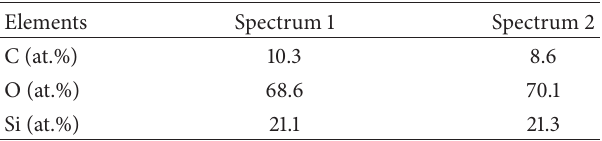
Table 3: The constituents of the black aggregates in the prepared WC-Ni cemented carbide with 3.75 wt.% SiC nanowhisker as shown in Figure 3(f). Elements Spectrum 1 Spectrum 2 C (at.%) 10.3 8.6 O (at.%) 68.6 70.1 Si (at.%) 21.1